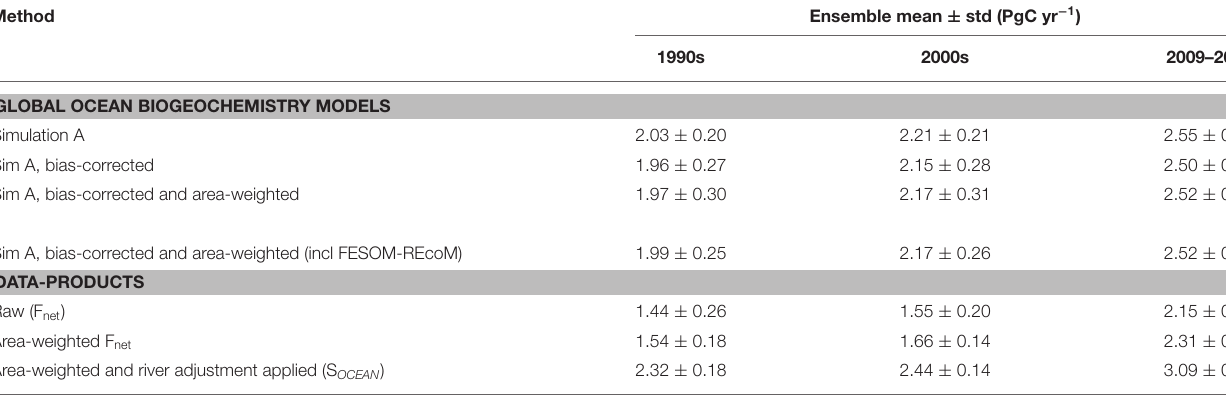
TABLE 3 | Ensemble mean and standard deviation of air-sea CO 2 flux before and after applying corrections.